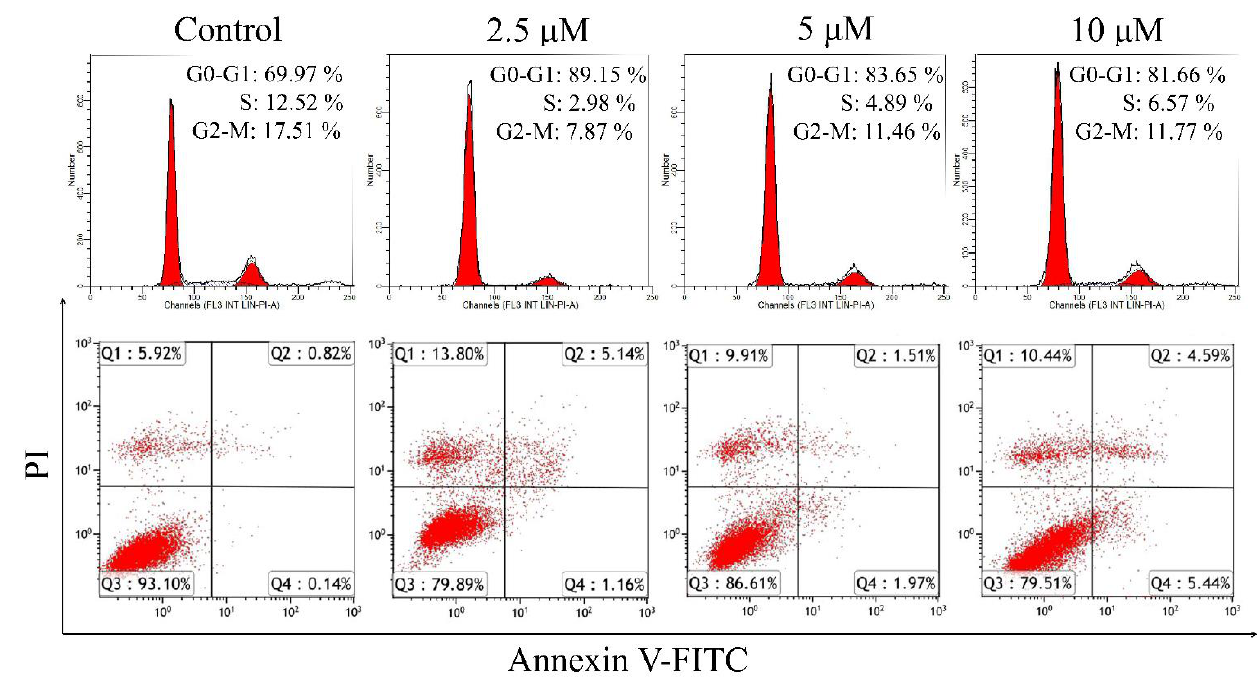
Figure 5. Apoptosis and cell cycle analysis of MCF-7 human breast cancer cells after 72 h of exposure to complexes 1 by flow cytometry using Annexin V-FITC vs. PI staining.